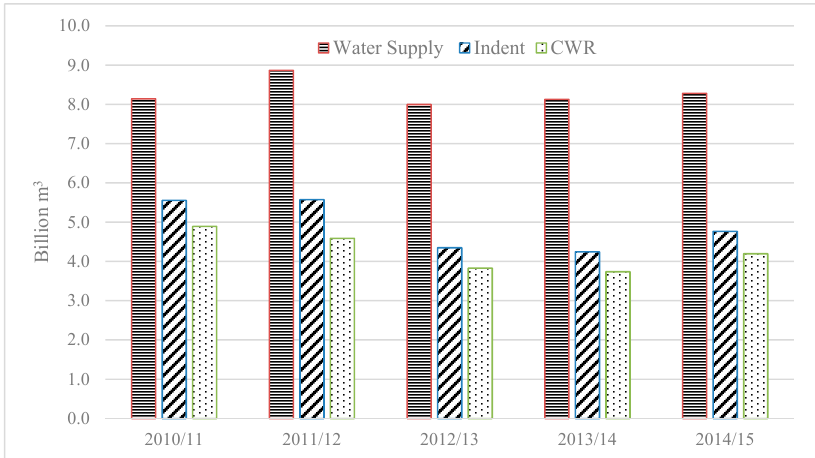
Figure 8. Water supply volume against Indent and CWR at SGB and WUAs period.